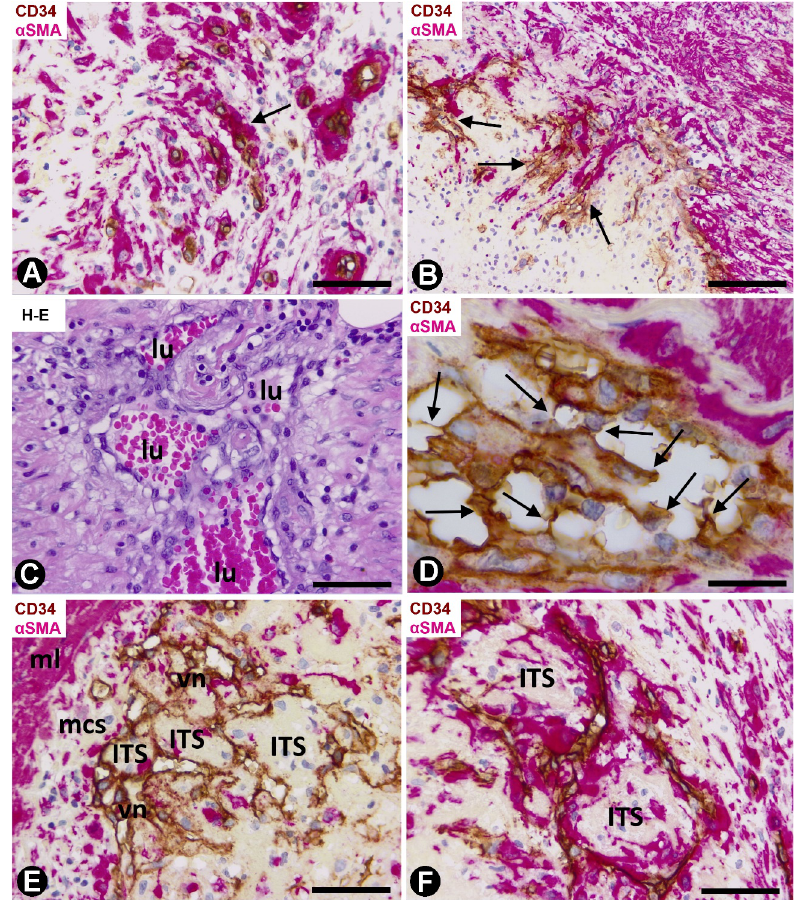
Figure 2. Arteries in gallbladders with acute cholecystitis and urgent cholecystectomy. Sections double-immunostained with anti-CD34 (brown) and anti- α SMA (red) ( A , B , D – F ) and stained with HE ( C ). ( A ) Numerous capillaries (arrows) in a cell-diminished artery media layer. ( B ) Endothelial cells (ECs) (brown) and vascular smooth muscle cells (VSMCs) (red) (arrows) in the arterial lumen. ( C ) Several lumens (lu) formed by ECs. ( D ) Presence of EC bridges forming arterial neolumens (arrows). ( E ) A complex vessel network (vn) is observed underlying the VSMCs (myointimal cells: mcs), which are under the muscular layer (ml) of the artery. Note the formation of loops, and ECs (brown) and α SMA+ cells in the neo-capillaries of the complex network. Interstitial tissue structures (ITSs) are also seen. ( F ) Detail of loops in the vessel networks. Note interstitial tissue structures (ITSs) surrounded by loops. Bar: ( B ): 100 μ m; ( A , E , F ): 80 μ m; ( C ): 70 μ m; ( D ): 10 μ m.